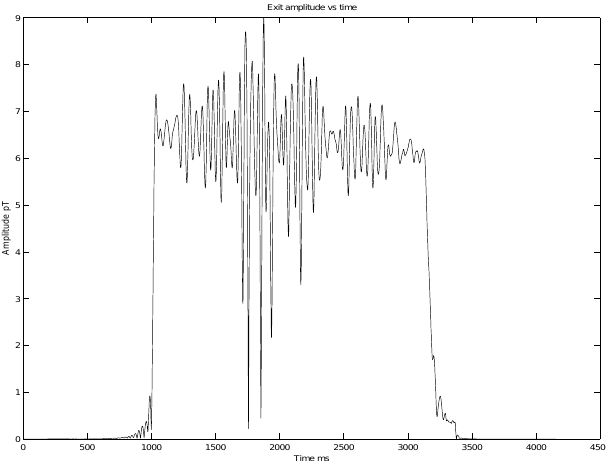
Fig. 1. Wave amplitude profile for the “base case”, measured at the downstream end of the simulation box, some 4000km from the equator on the receiver side. The duration of the emission is ∼ 2.2s. Time is measured from the start of the simulation when the trigger- ing pulse enters the simulation box.